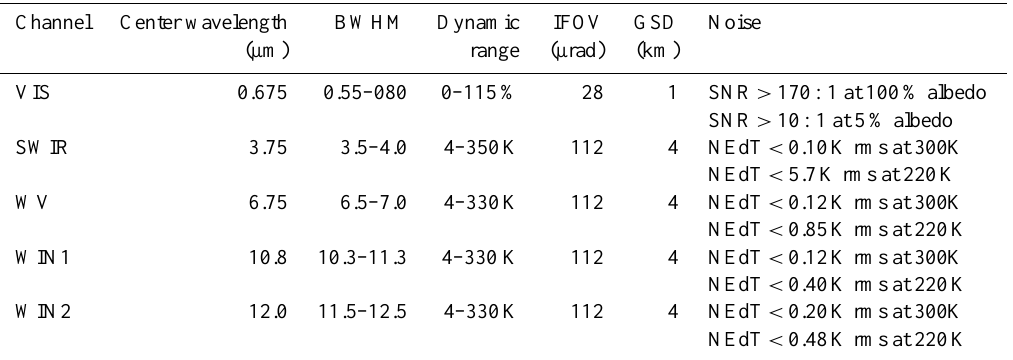
Table 1. Specifications of COMS/MI user requirement. Note that the dynamic range of SWIR goes up to 350K to accommodate the daytime contribution of solar